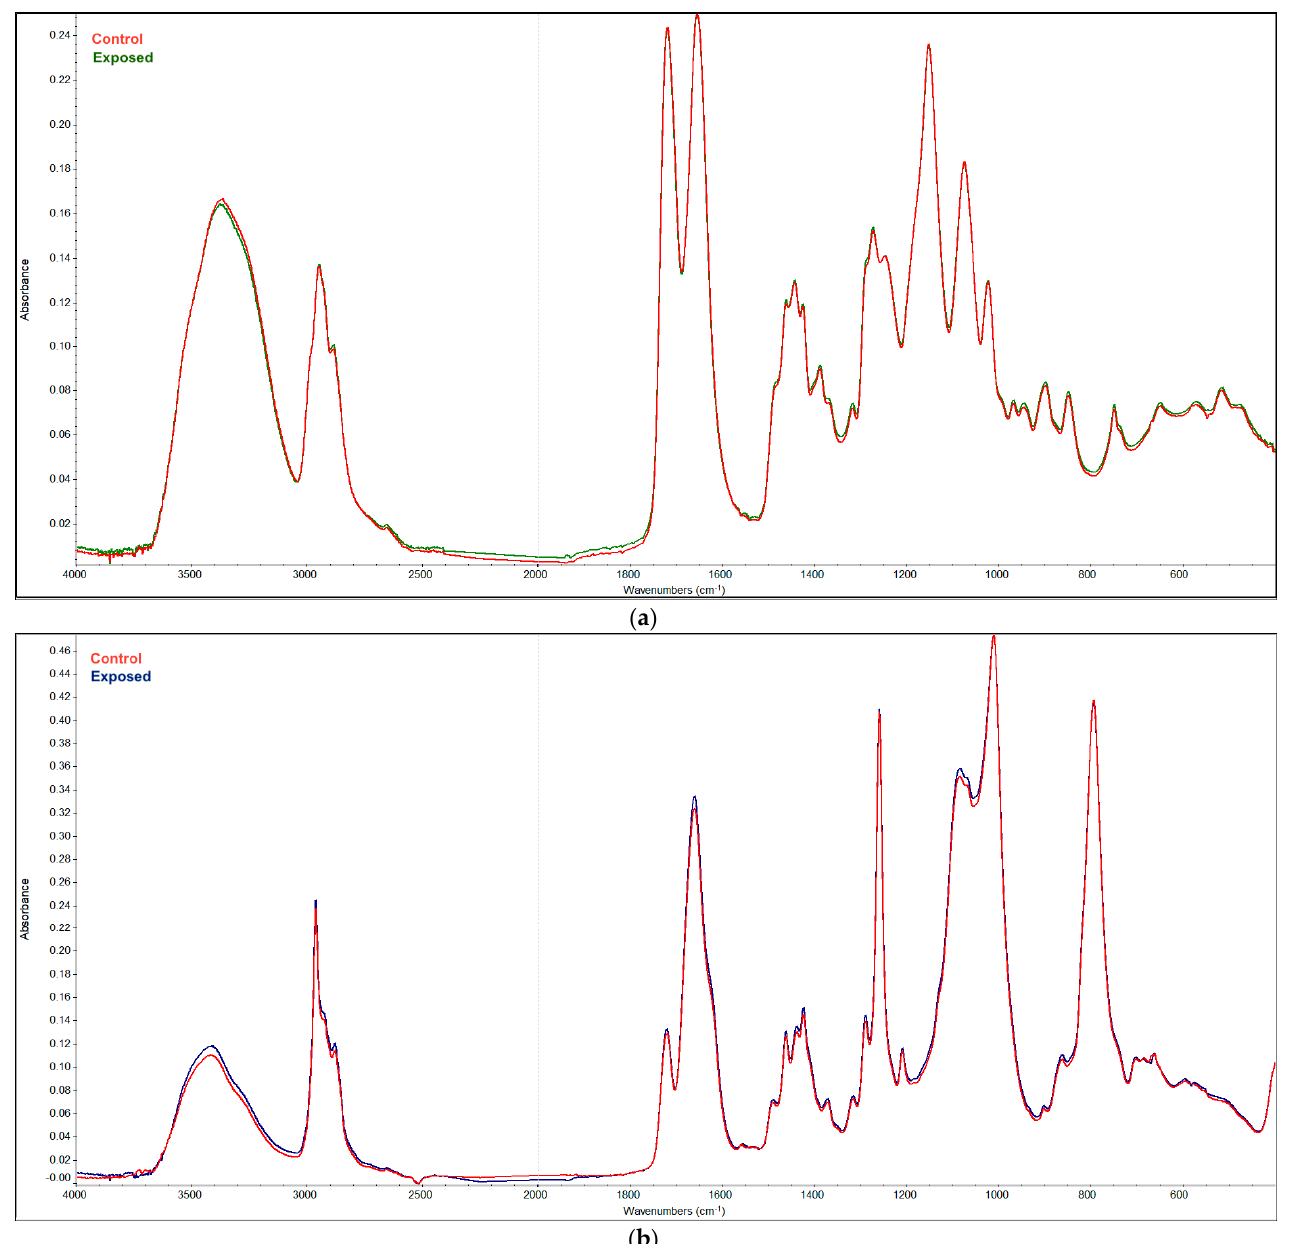
Figure 2. Cumulated FTIR spectra of Soflens ( a ) and Biofinity ( b ) CLs before and after plasma exposure for 90 min. The same effect is evident in Figure 3, showing superimposed Raman spectra of the CLs before and after plasma exposure for 90 min.